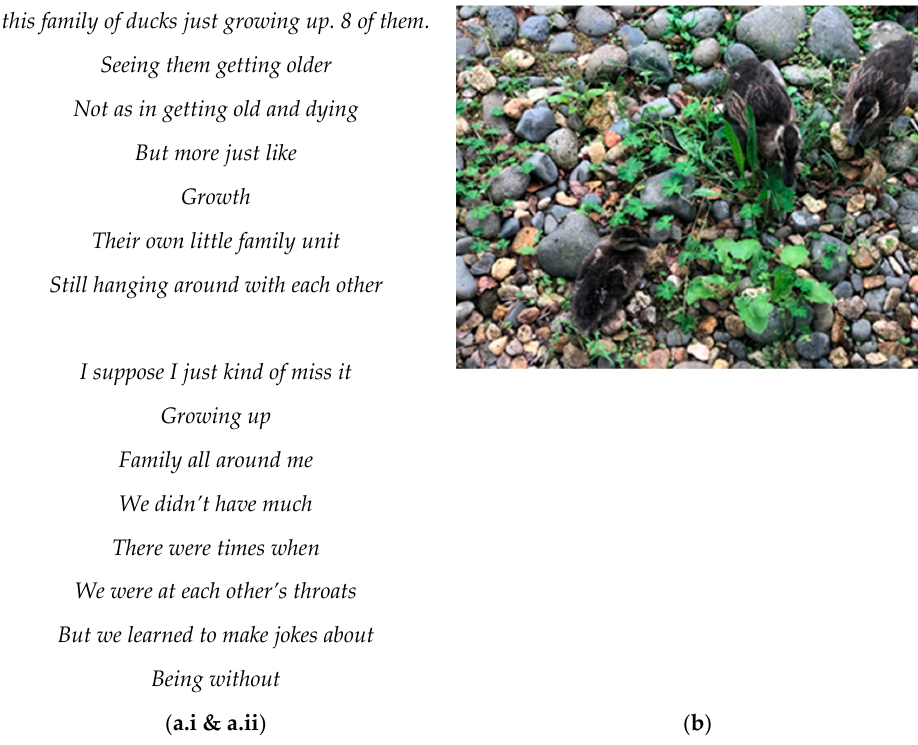
Figure 1. This figure depicts ( a.i ) Stanza 1 of the poem; ( a.ii ). Stanza 2 of the poem; ( b ) A picture of